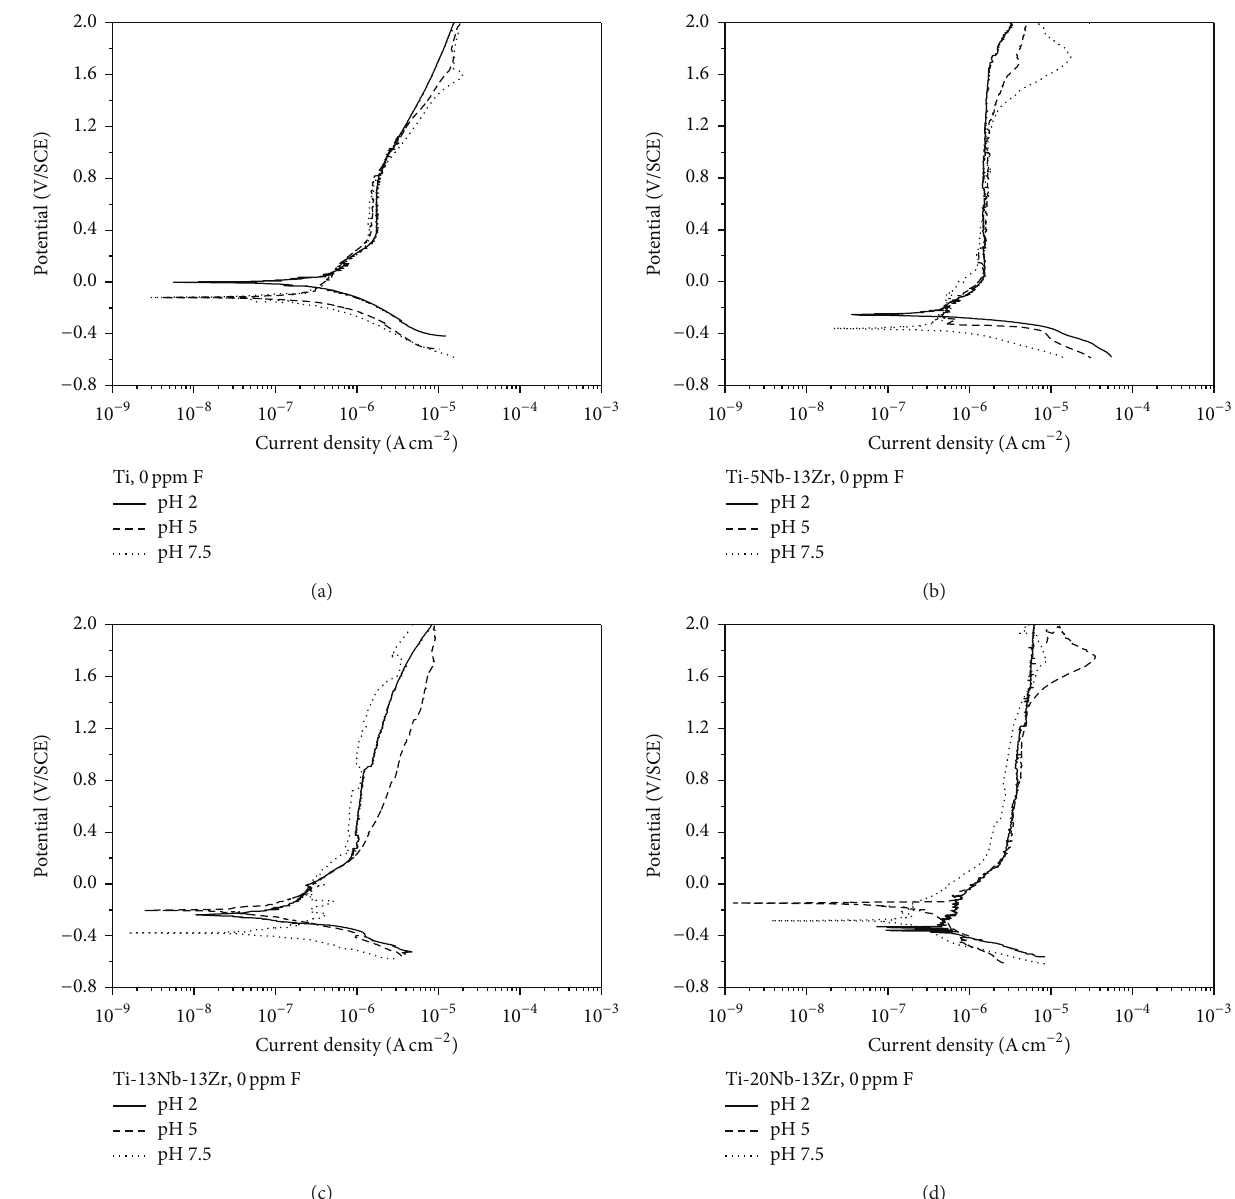
Figure 3: Polarization curves of (a) CP-Ti, (b) Ti-5Nb-13Zr, (c) Ti-13Nb-13Zr, and (d) Ti-20Nb-13Zr in Ringer’s solution of pH 2, 5, and 7.5 at 37 ∘